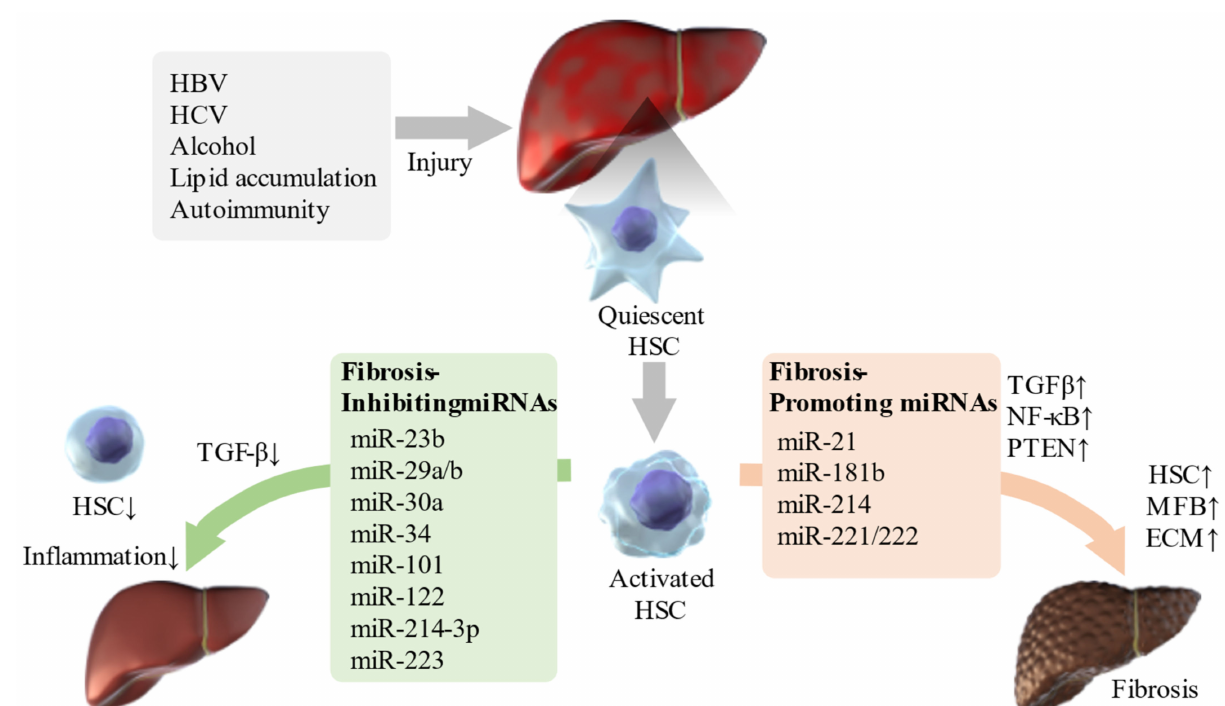
Figure 1. Schematic diagram of the relationship between miRNAs and liver fibrosis. HSCs are activated in livers damaged by viruses, alcohol, lipid accumulation, and autoimmunity. Various miRNAs are involved in this process and affect molecules such as TGF- β , NF- κ B, and PTEN, which are involved in different pathways. This can improve inflammation or, conversely, result in ECM accumulation and cirrhosis. HSC: hepatic stellate cell; TGF- β : transforming growth factor- β ; NF- κ B: nuclear factor-kappa B; PTEN: phosphatase and tensin homolog; MFB: myofibroblast; ECM: extracellular matrix; miRNA: micro ribonucleic acid; HBV: hepatitis B virus; HCV: hepatitis C